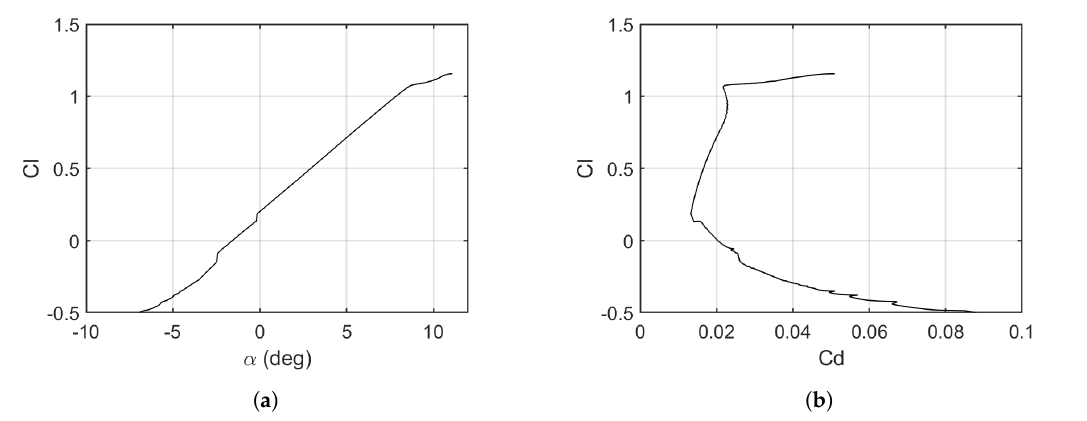
Figure 6. Phoenix airfoil characteristics. ( a ) Lift curve. ( b ) Drag polar.